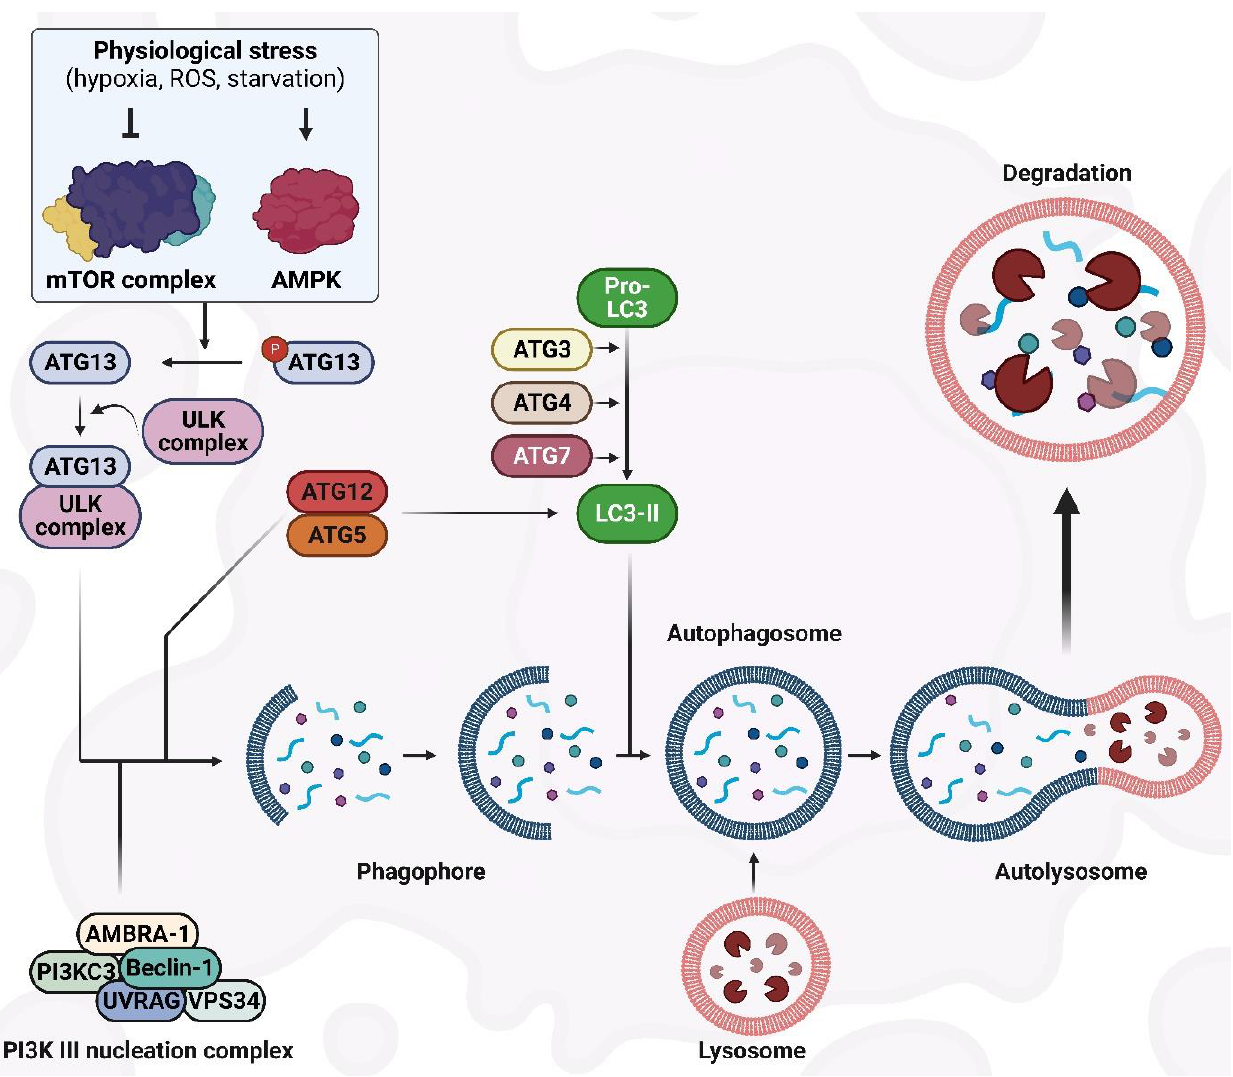
Figure 2. The autophagy machinery and its regulatory mechanisms.